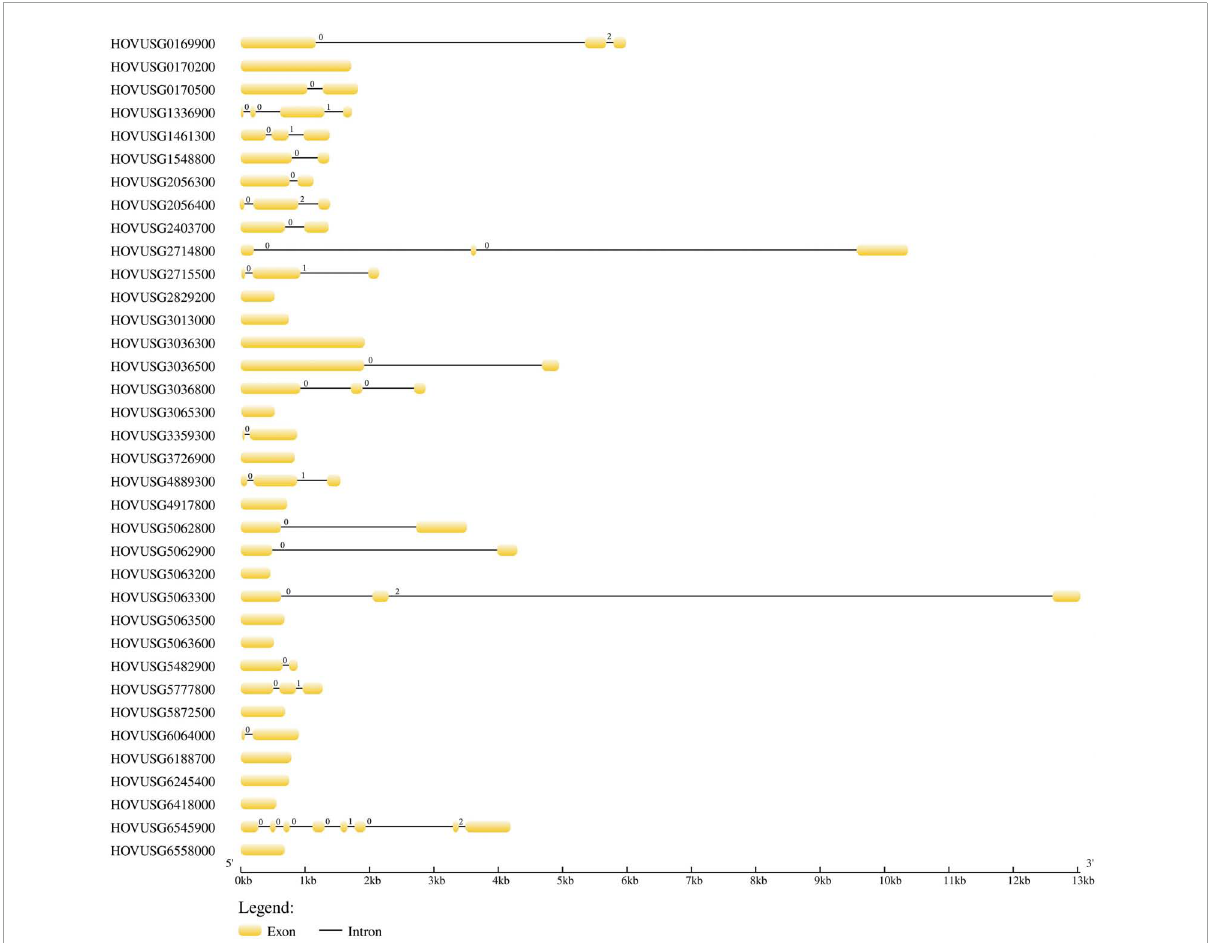
FIGURE3 Exon–intron structure of the Qingke TLP genes. Yellow boxes and black lines respectively indicate the exons and introns. The numbers (0, 1, and 2) indicate phases of